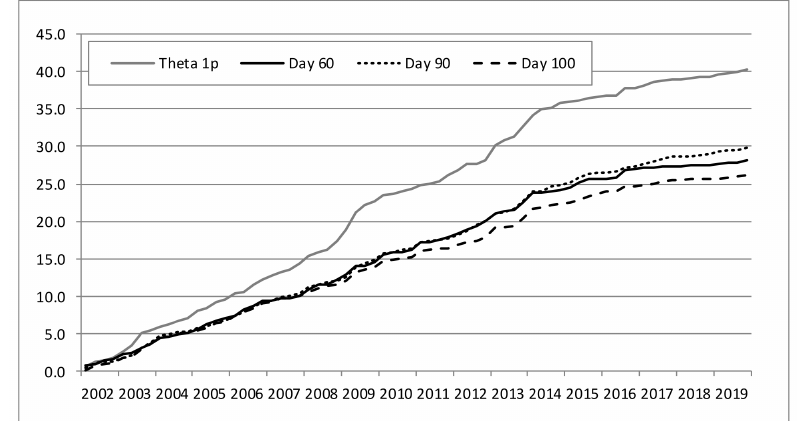
Figure 7. Cumulative absolute out-of-sample forecast error of the median of Models 1 to 6 with last- error correction given the data available at days 60, 90 and 100 of the current quarter compared with the one-step-ahead Theta forecast (percentage points,